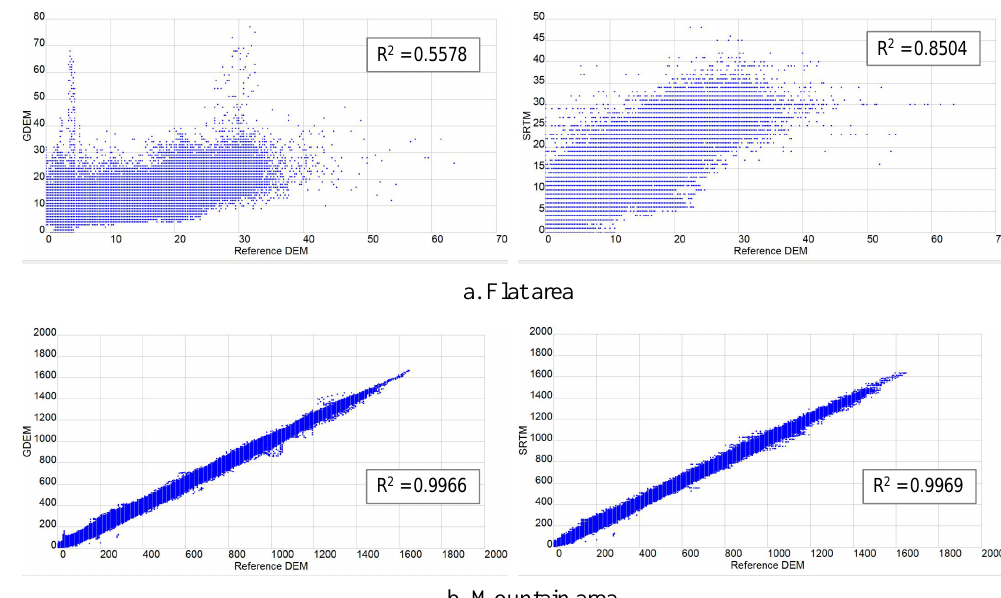
Figure 6. Correlation of GDEM and SRTM in flat (a) and mountainous (b) area.